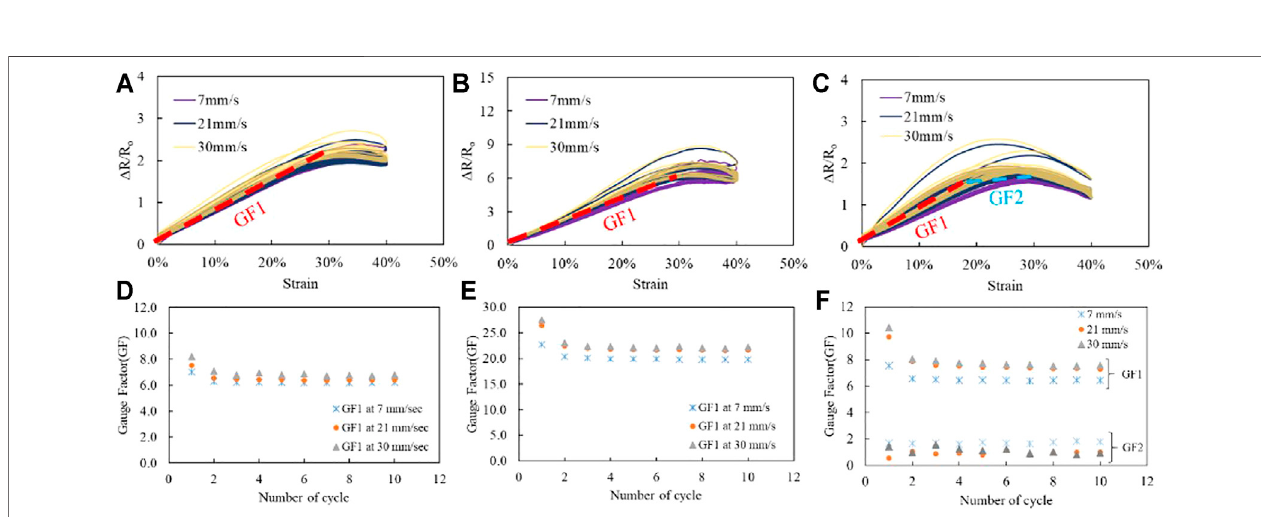
FIGURE 10 | Electromechanical characteristics of the stretchable strain sensors: (A) PDMS-PEIE/MWCNTs-1, (B) PDMS-PEIE/MWCNTs-2 and (C) PDMS-PEIE/ MWCNTs-3. Gauge factors (GFs) of (D) PDMS-PEIE/MWCNTs-1, (E) PDMS-PEIE/MWCNTs-2, and (F) PDMS-PEIE/MWCNTs-3.